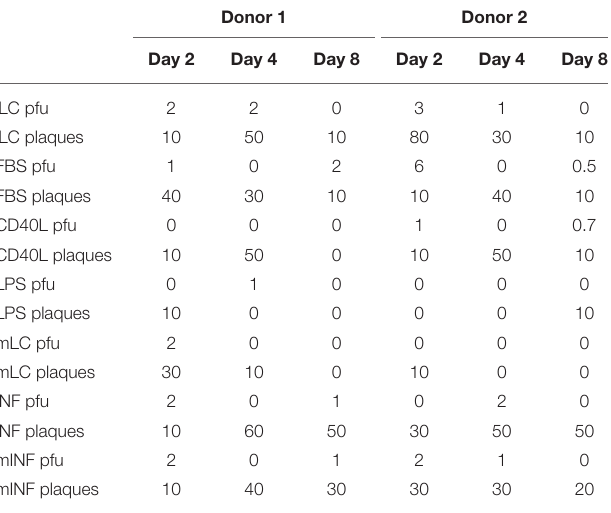
TABLE 1 | Viral particle content per 10 5 cells in the supernatant of cells differentiated from latently infected CD34 + progenitors (Pfu) and number of plaques per 10 5 cells obtained after their co-culture with HFF (Plaques).